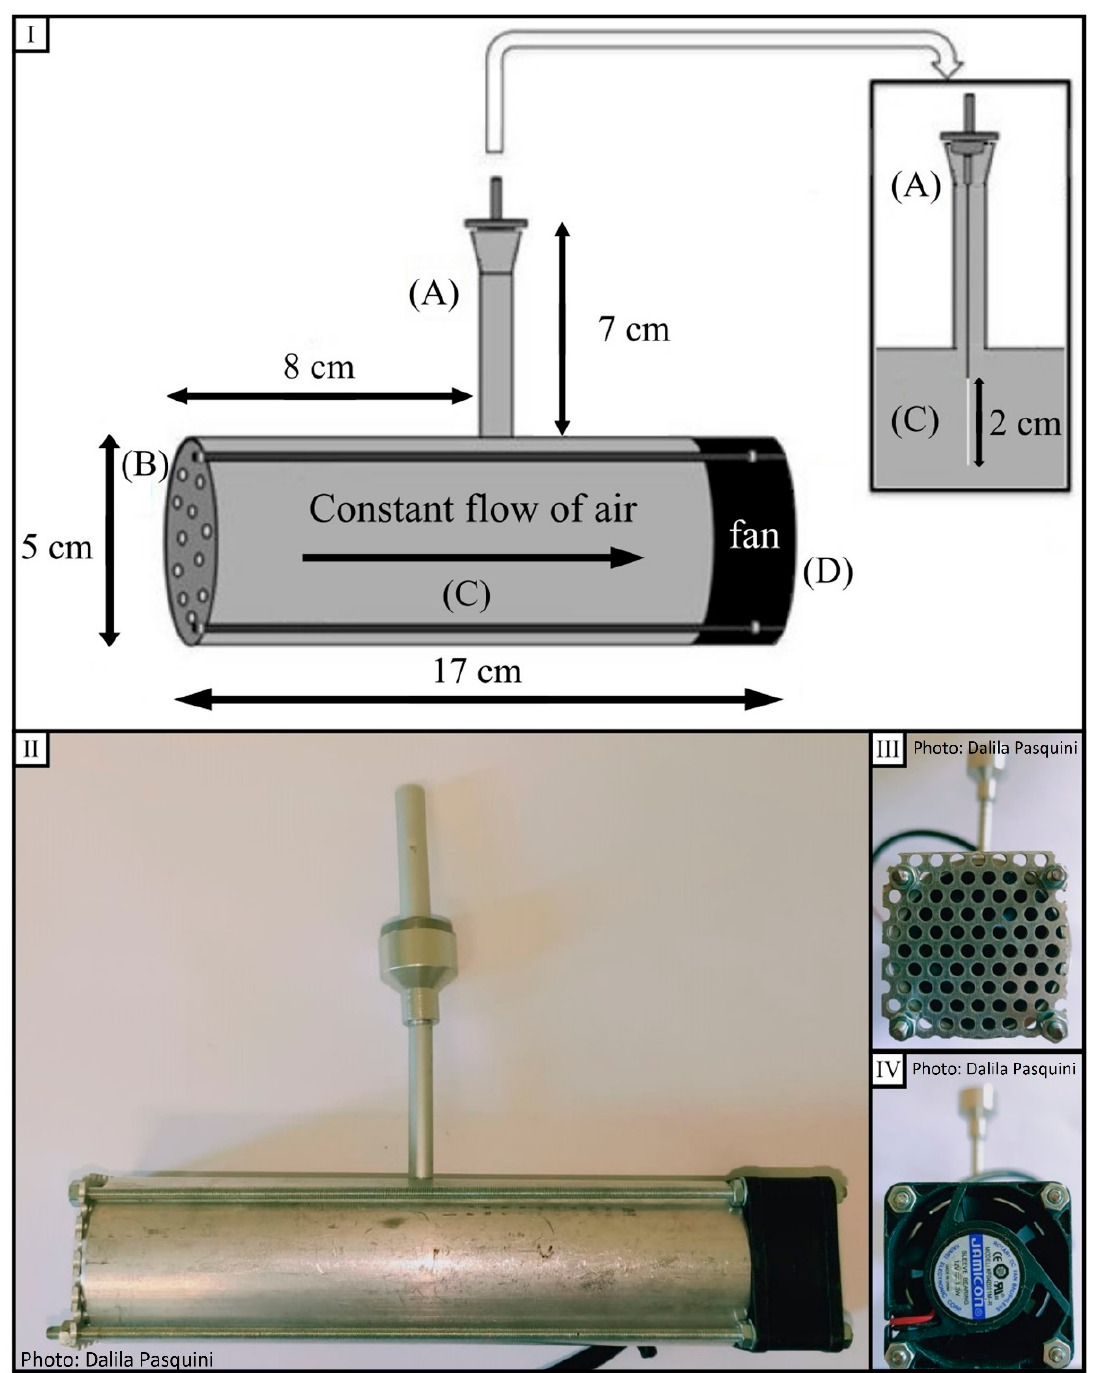
Figure 6. In panel I , the schematic drawing of the dynamic sampling system, adapted and modified by the BVOC system developed by Barreira et al. [36], is reported. The SPME fiber was firmly positioned in the appropriate vertical tube ( A ) by four small magnets. A metal net ( B ) was installed at one end of the cylinder ( C ) to protect the fiber, while at the opposite end, a fan ( D ) was positioned to create a swirling flow. All parts are linked together by screws. In panel II , a picture of the whole device is reported, while in panel III and IV , the details of the net located in the front of the device and the fan set on the back are shown.